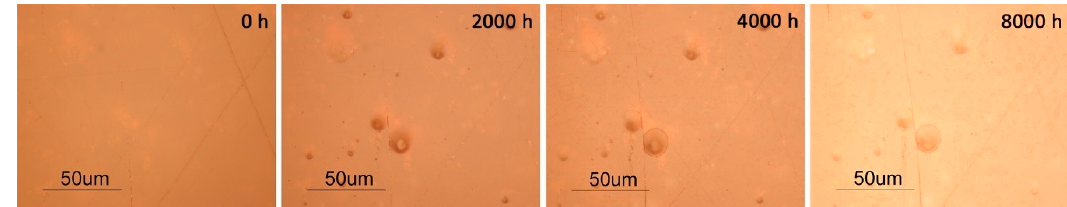
Figure 9. OM images of the surface of an RPS sample during artificial aging; acquired under reflected light and in bright-field mode. light and in bright-field